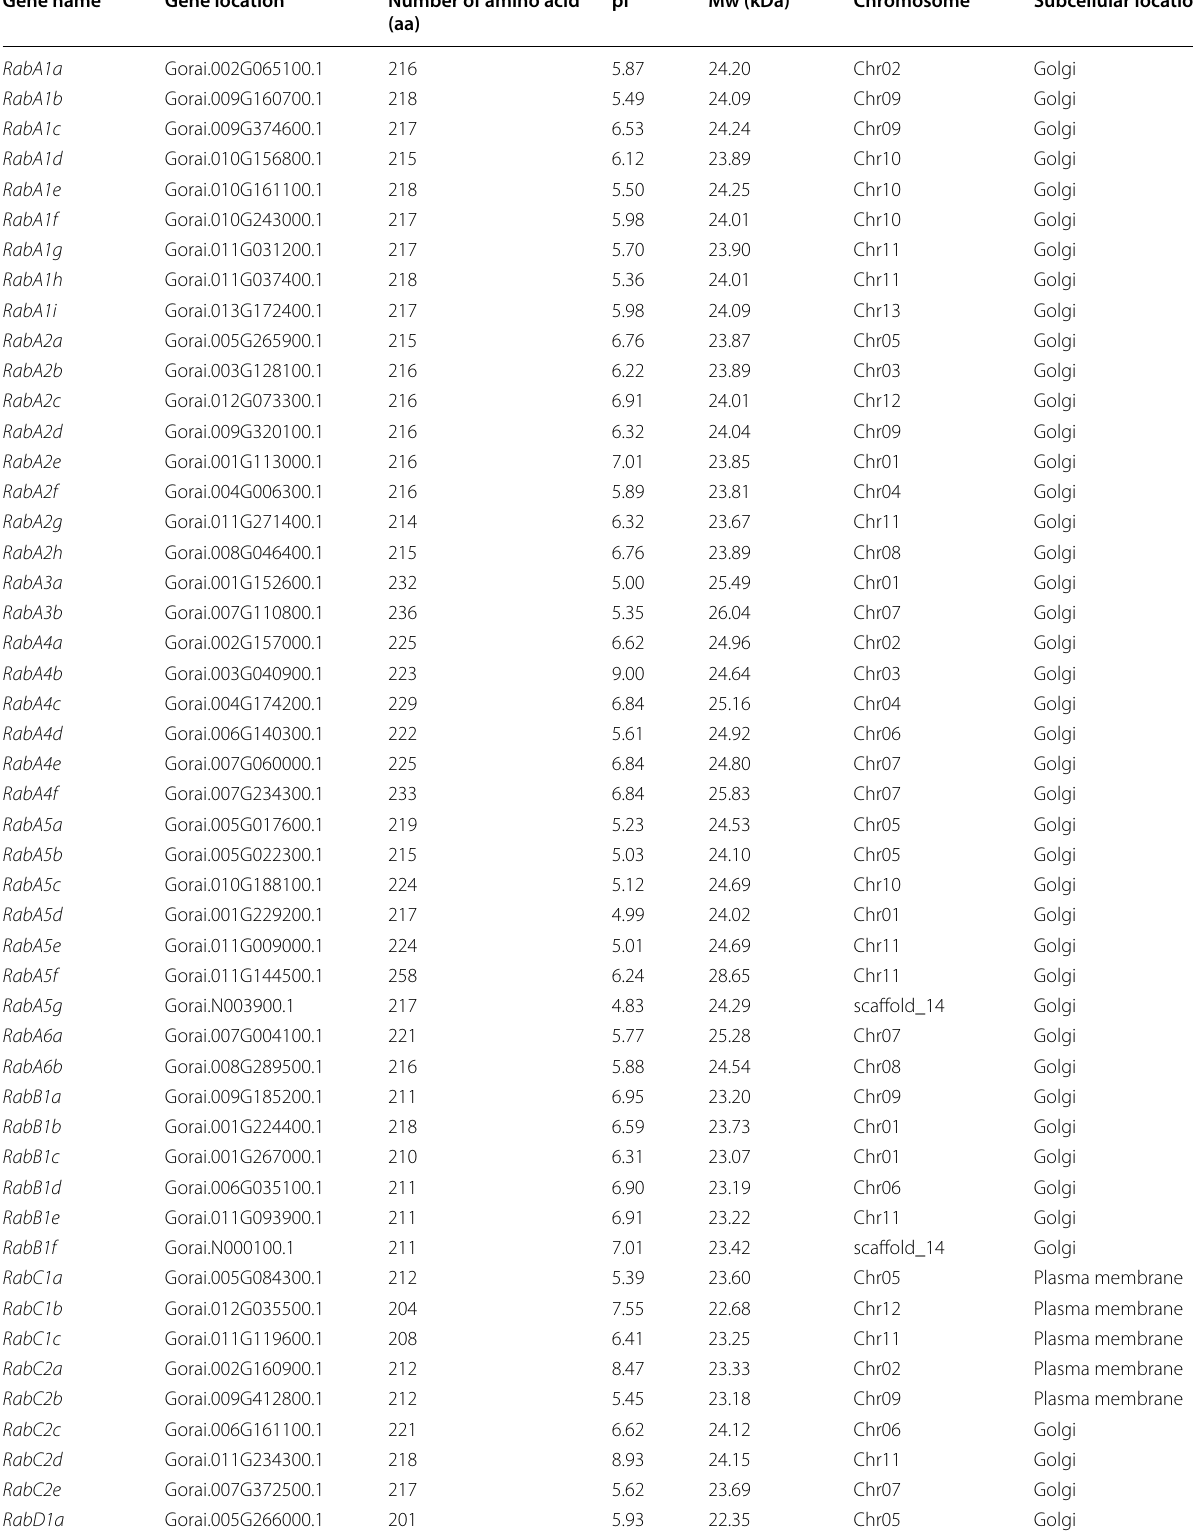
Table 1 Basic bioinformatics analysis of Rab gene family in G.